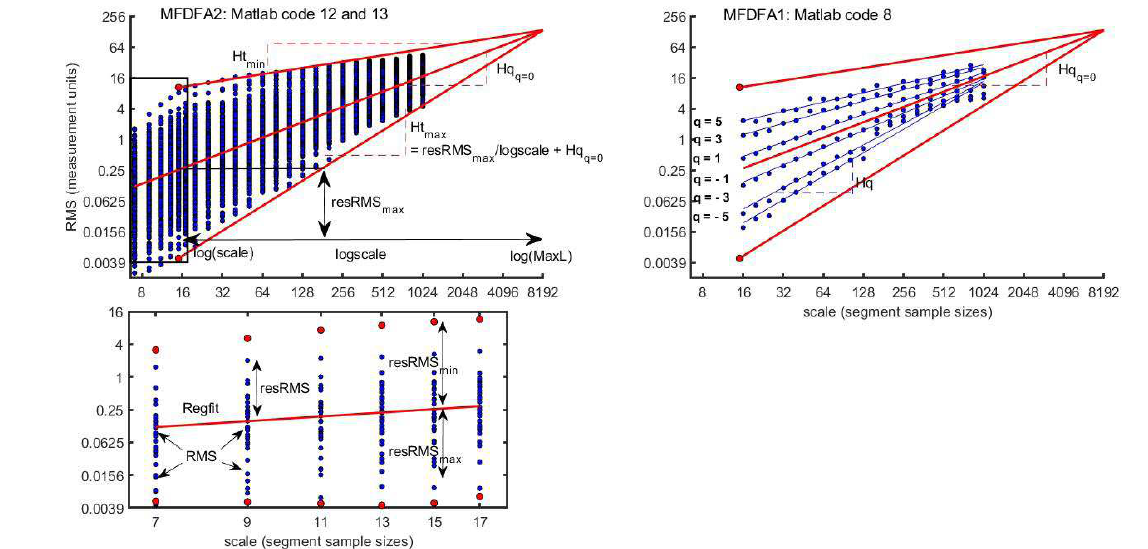
Figure 8. Estimation of the Hurst